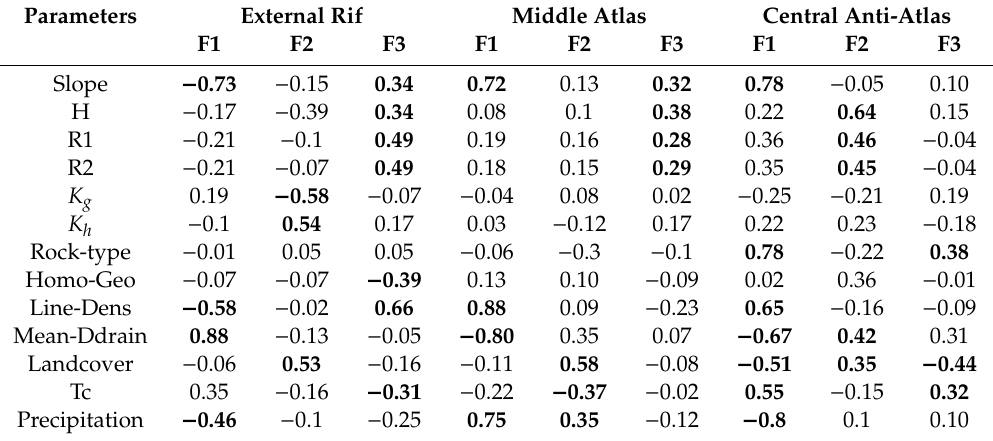
Table 8. Correlations between variables and discriminant functions of the three study areas (higher values are in